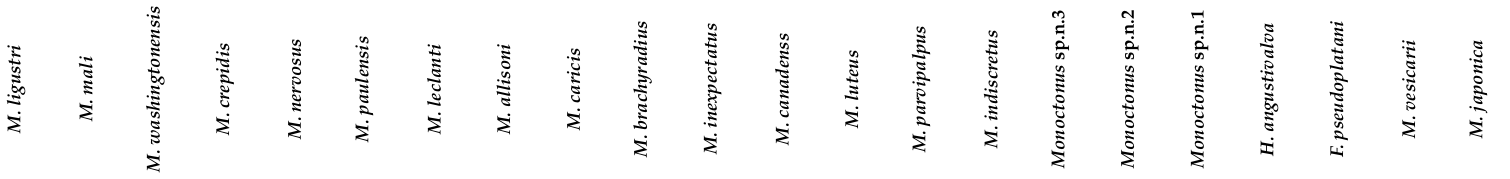
Table 1. Genetic distances between Monoctonina species based on COI